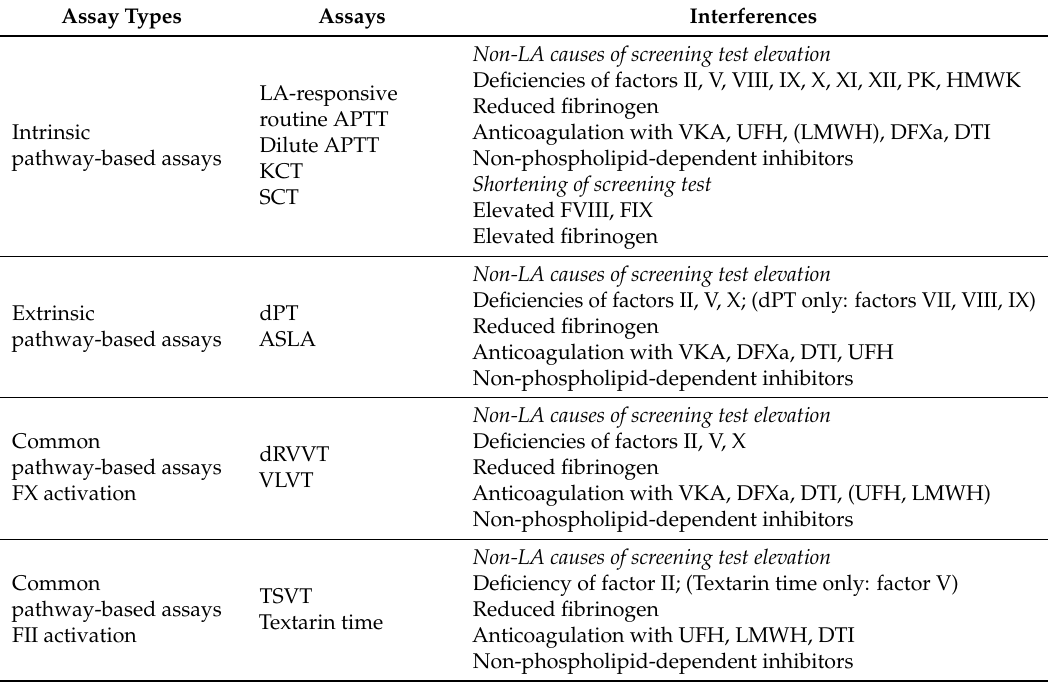
Table 1. Main interfering factors in lupus anticoagulant assays affecting